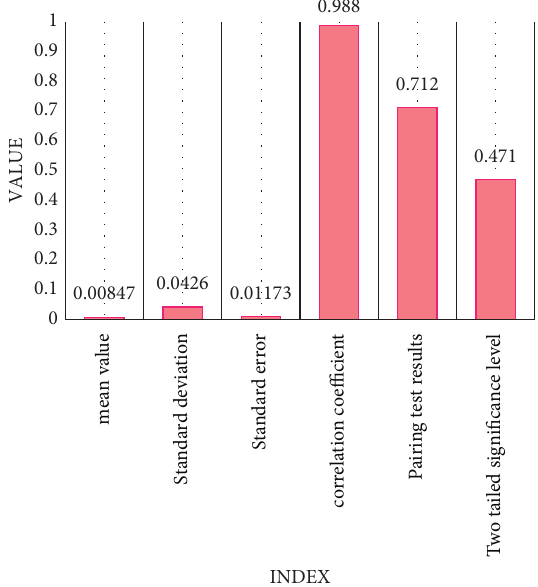
Figure 9: Sample inspection before and after